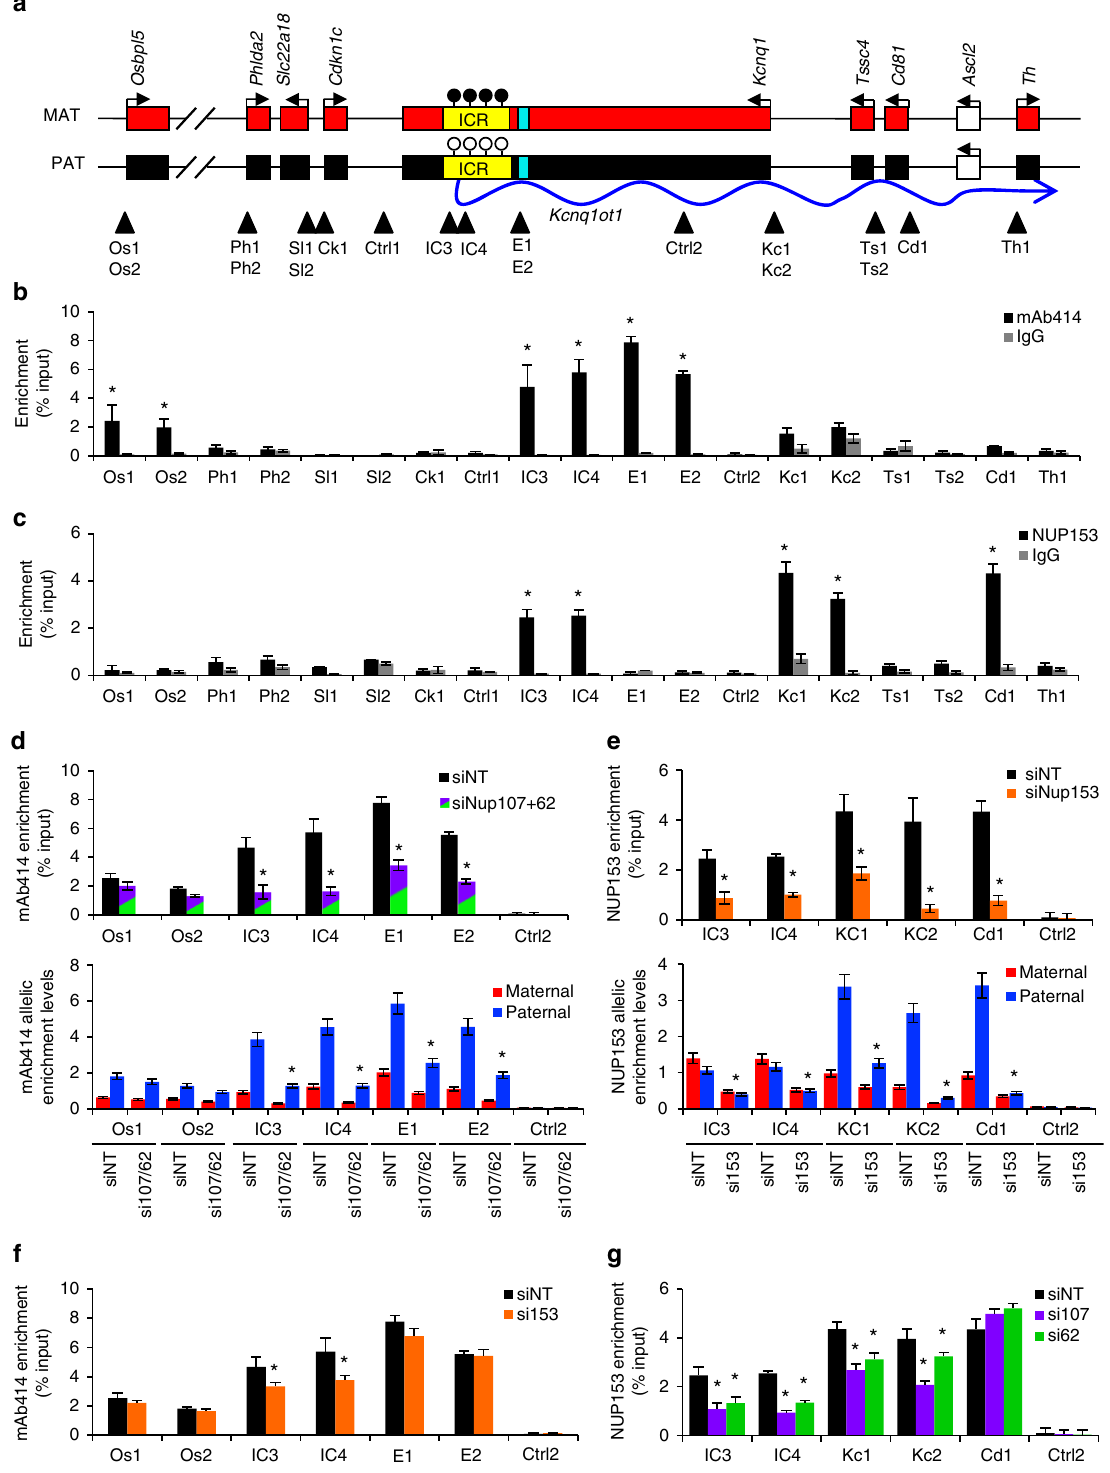
Fig. 3 NUP107/62 and NUP153 interaction with the Kcnq1ot1 ICR, and the Osbpl5, Kcnq1, Cd81 promoters. a The Kcnq1ot1 domain with regions of